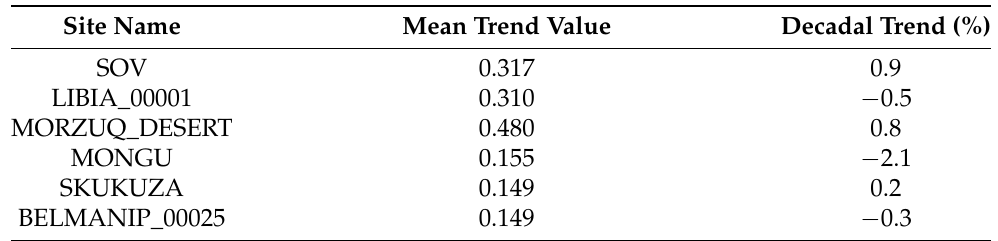
Figure 7. MONGU DHR30 time series. The location of the site is shown in the map on the right hand side. Upper plot: monthly averaged broadband DHR30 (red), trend component (green) and trend linear regression (dashed blue). Bottom plot: Auto correlation function (ACF) up to 24 months for the monthly averaged broadband DHR30 (red dots) and for the trend component (green diamonds). The corresponding 95% confidence regions are also displayed. Only lags inside those areas are statistically significant. Table 6. Mean trend value (absolute value) and decadal trends (percentage) over thirty-six years for the desert, urban the shrub validation